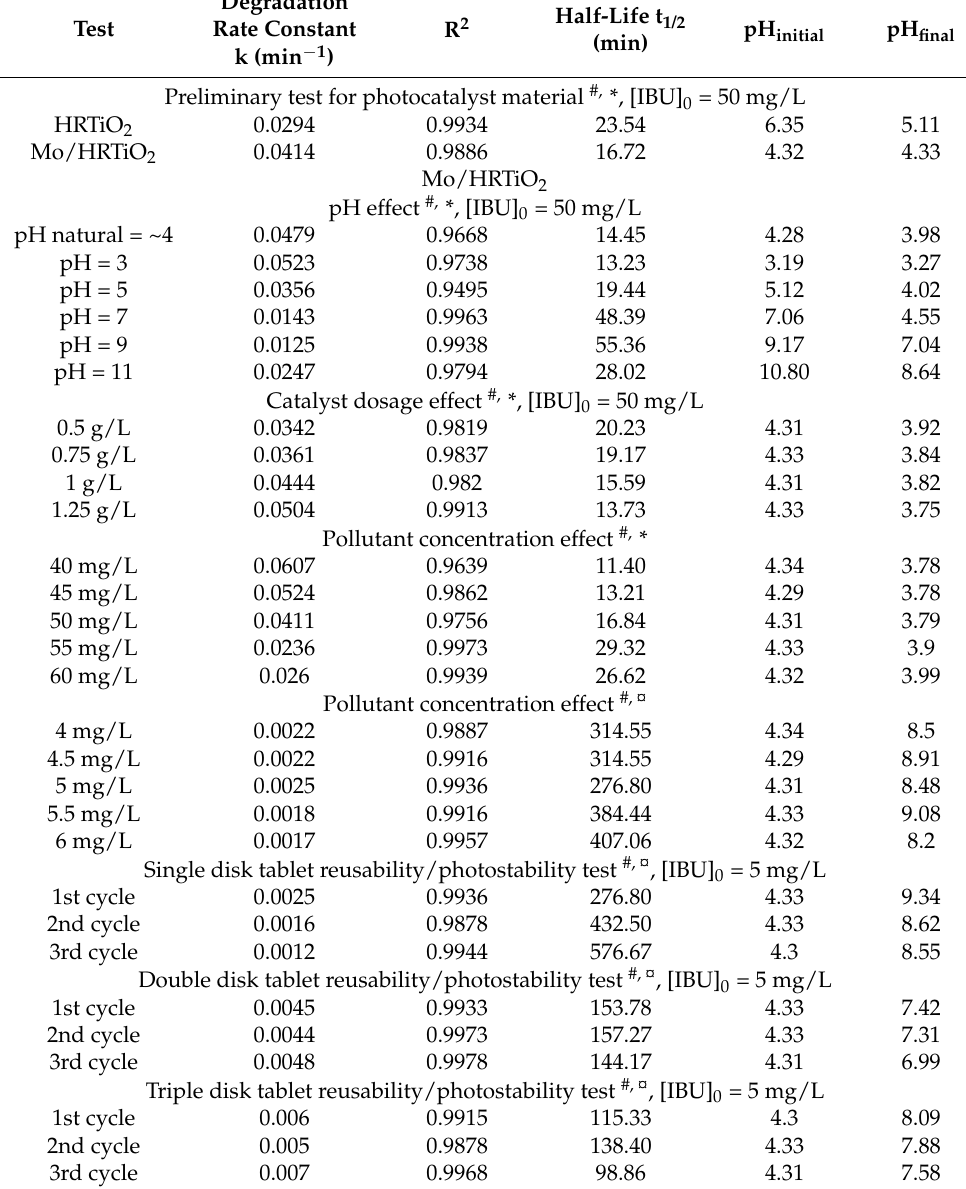
Table 4. Parametric indicators for the photocatalytic activity performance evaluation of Mo/HRTiO 2 . In suspension and on support tests over ibuprofen showing investigated parametric effects and their estimated degradation rate constant k (min − 1 ), correlation coefficient R 2 , half-life t 1/2 (min), and measured initial and final pH